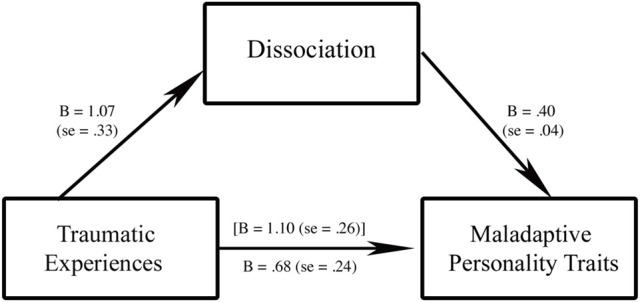
The mediating role of dissociation in the relationship between traumatic experiences and maladaptive personality traits. Traumatic experiences, Traumatic Experiences Checklist total score; Dissociation, Dissociative Experiences Scale–II total score; Maladaptive Personality Traits, The Personality Inventory for DSM-5-Brief Form total score; values in bracket square indicate the relationship between traumatic experiences (predictor) and maladaptive personality traits (outcome) without the inclusion of dissociation (mediator); all p < 0.01.